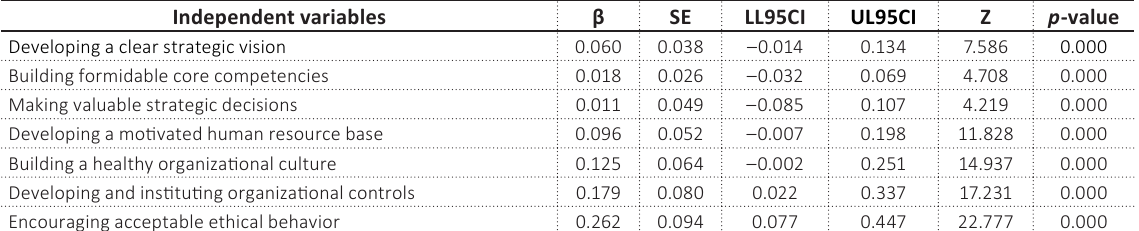
Table 10. Sobel mediation analysis